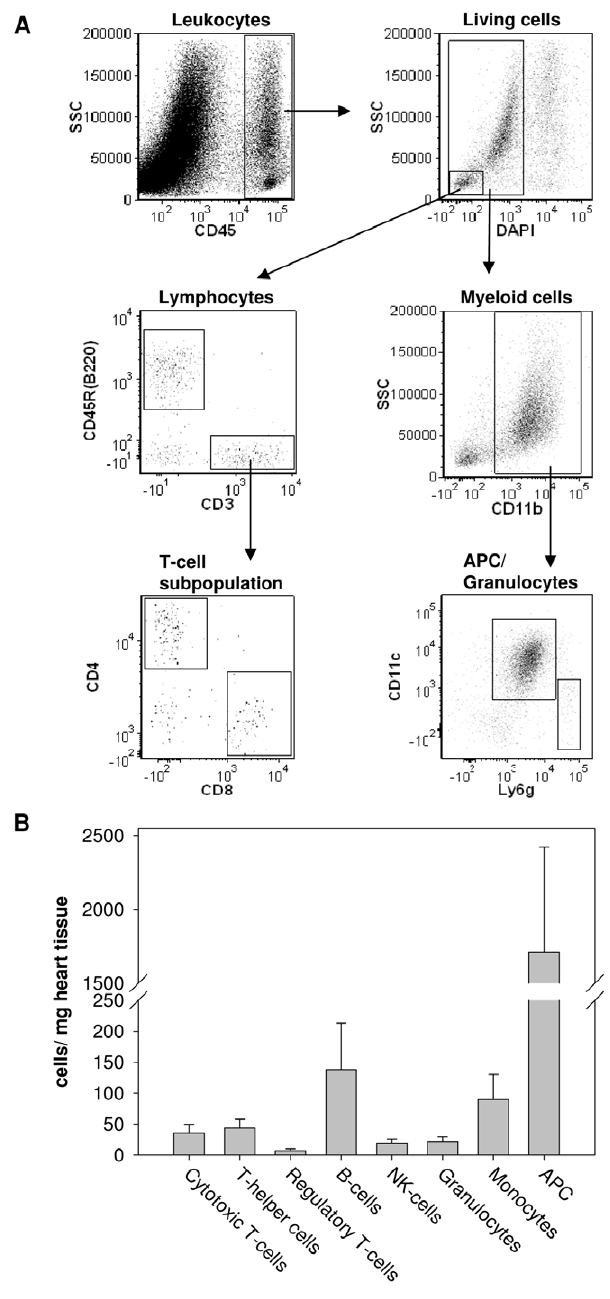
Figure 2. Leukocyte subpopulations in myocardial tissue under basal conditions. A: Gating strategy used to identify different leukocyte subpopulations by multiparametric flow cytometry. CD45 + cells were gated and DAPI-staining was used to exclude dead and apoptotic immune cells. Living CD45 + cells were then divided in subleukocyte populations using a panel of cell-specific fluorochrome- labeld antibodies. Lymphocytes were gated into CD45R(B220) + cells (B- cells) and CD3 + cells (T-cells). T-cells were subdivided in CD4 + cells (T- helper cells) and CD8 + cells (cytotoxic T-cells). Myeloid cells were characterized as CD11b + cells and further subdivided in CD11c + cells (APCs) and Ly6g + cells (granulocytes). B: Leukocyte subpopulations in the unstressed heart. Values are means 6 SD of n=5 experiments.